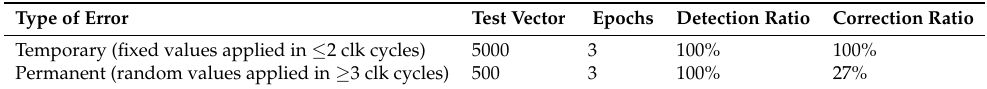
Table 6. Fault injection test